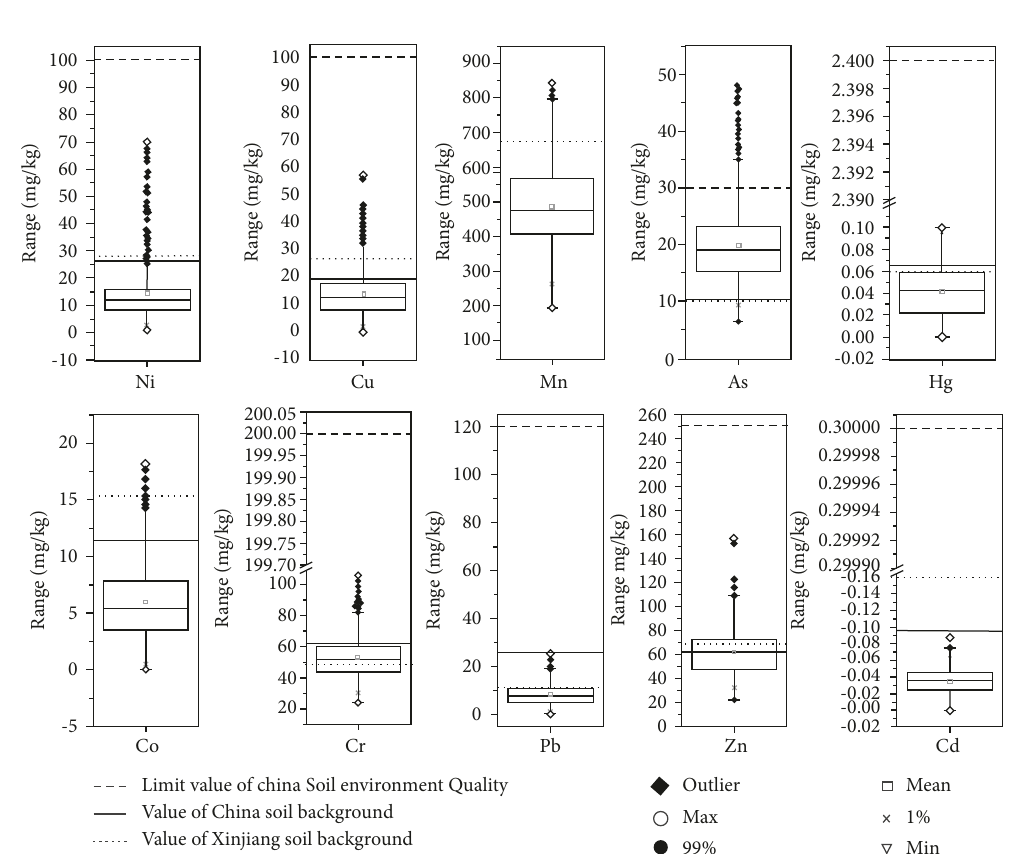
Figure 3: Statistical characteristics of the ten elements in the soils of the Aibi lake